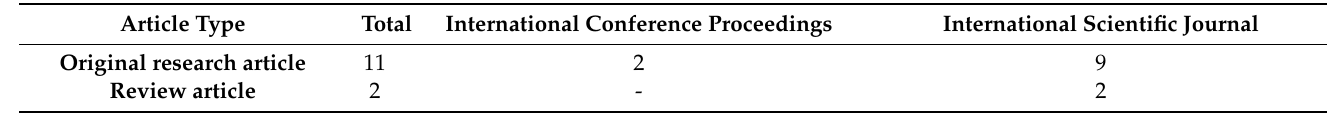
Table 2. Summary of the publication types and editorial collocation, i.e., journal or conference proceedings, of 13 papers thoroughly analyzed in the present